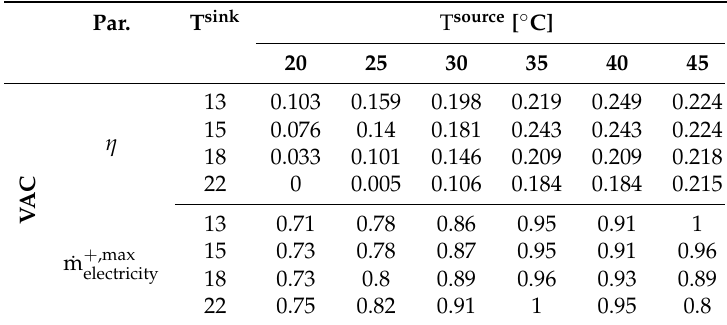
Table A4. Default parameters values for the VAC second-law efficiency and part-load limit, evaluated from [49]. Par.